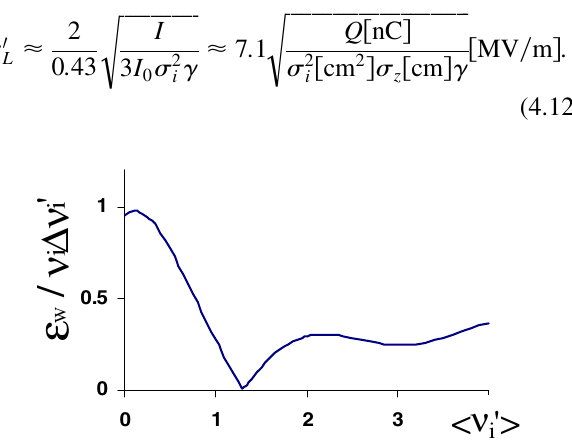
=(cid:6) ) (cid:2) (cid:6) 0 W i i j (cid:2) 1 : 3 . In reality, this i